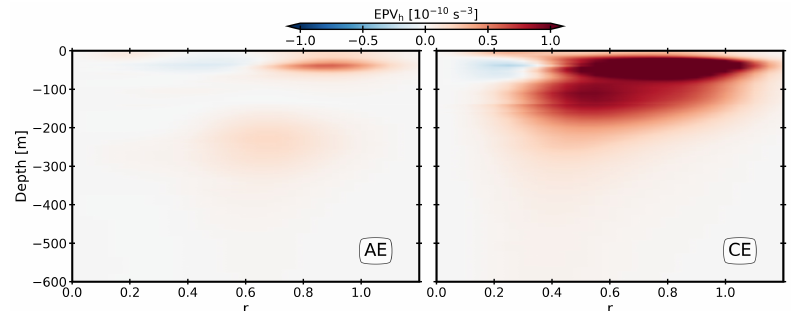
Figure 18. The horizontal component of the EPV for the CE and AE.